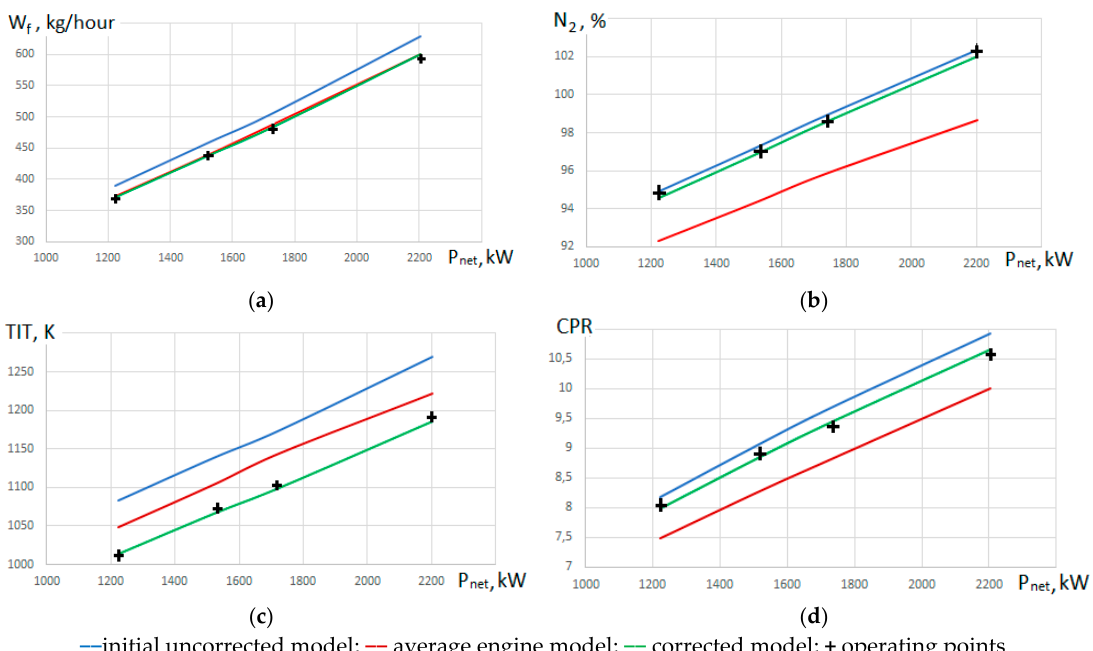
Figure 8. Experimental data vs models. ( a ) fuel flow; ( b ) high pressure rotor rotation speed; ( c ) turbine inlet temperature; ( d ) compressor pressure ratio.